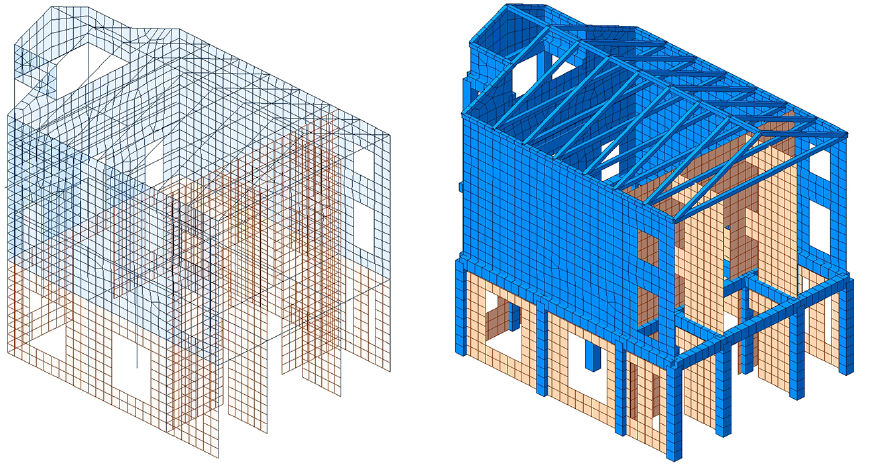
Figure 9. Wireframe ( left ) and solid ( right ) representation of the finite element model used for the modal analysis of the central